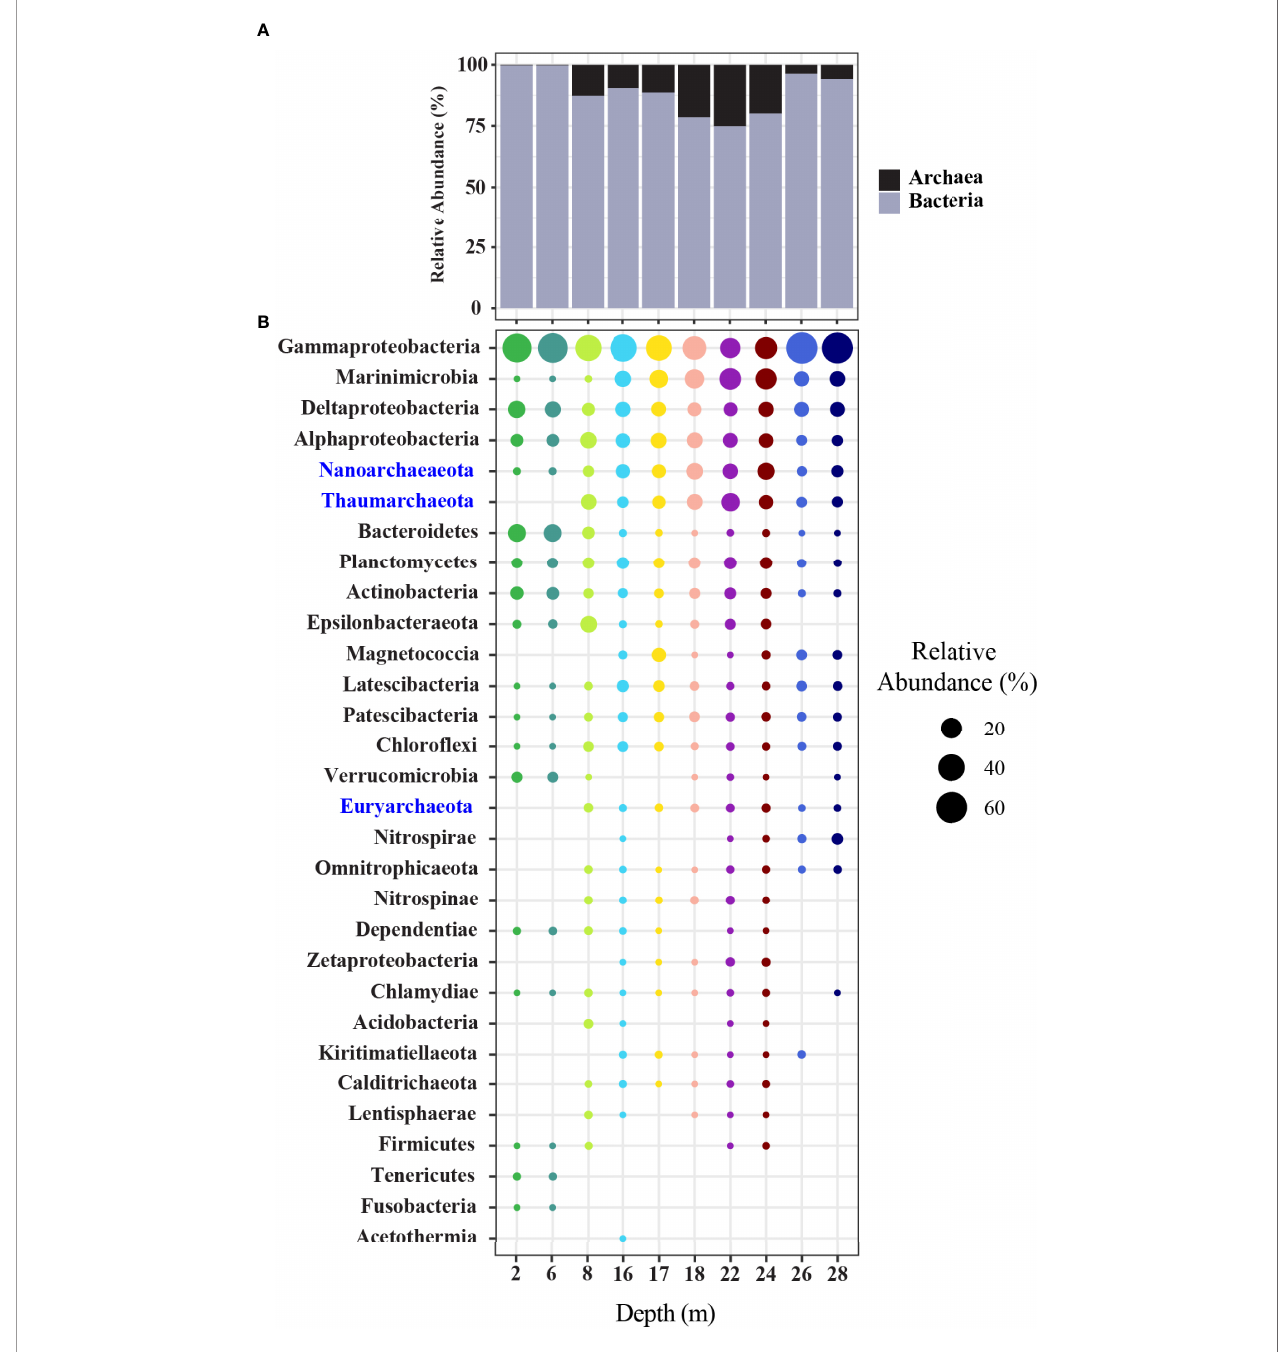
FIGURE 5 | (A) Bar chart displaying the summed composition and relative abundance of Archaea and Bacteria. (B) Dot plot displaying the composition and abundance of the top 30 most abundant phyla (Proteobacteria shown at class level). Archaeal phyla names are shown in